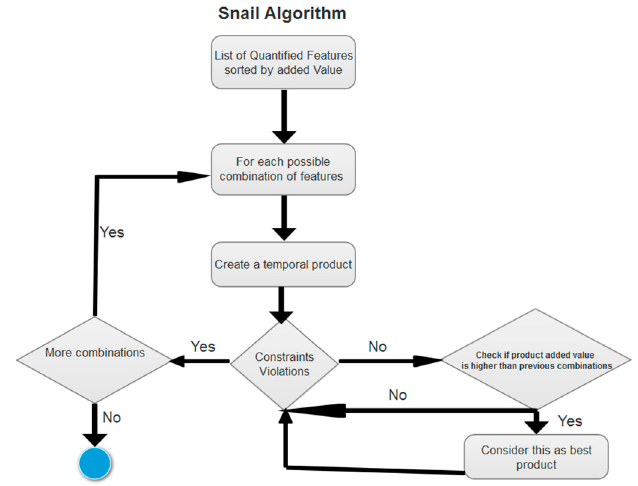
Figure 4. The Snail features selection algorithm.